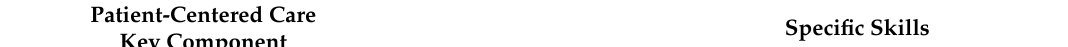
Table 1. Skills of Patient-Centered